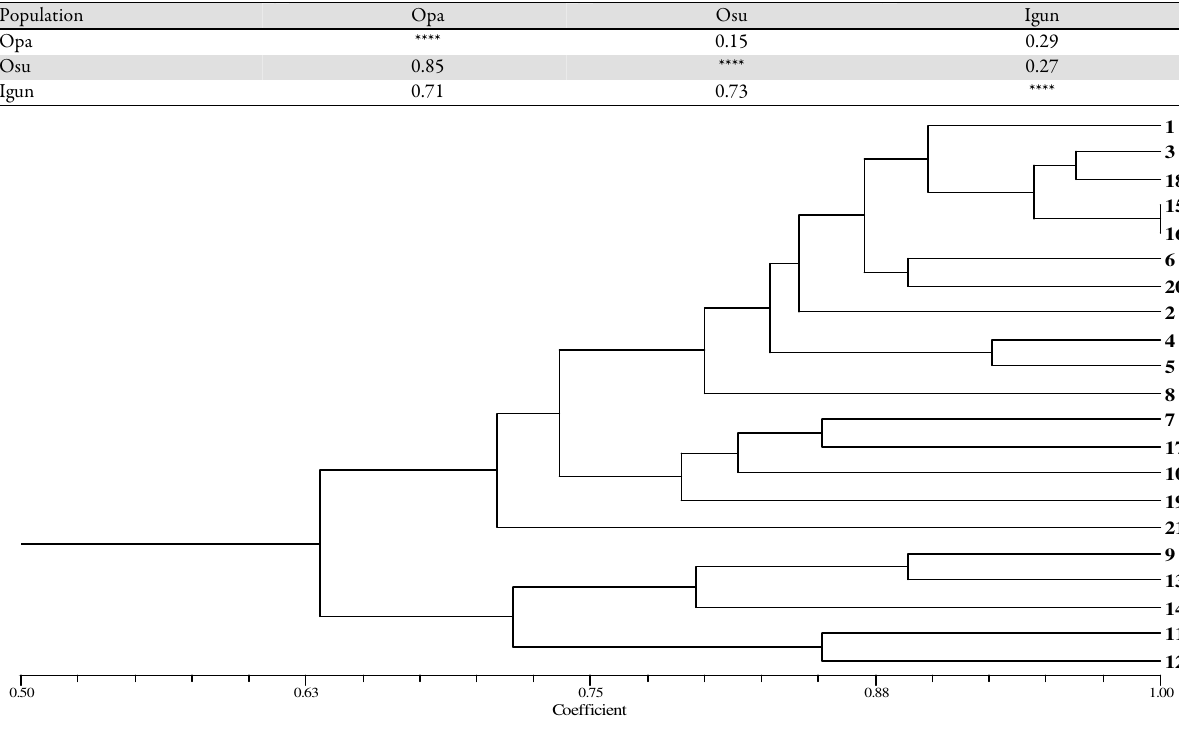
Coefficient Fig. 6. UPGMA dendrogram, summarizing the data on differentiation between Tilapia zillii populations, according to RAPD analysis. Samples 1-7 is from Opa Reservoir, samples 8-14 is from Osu Reservoir and samples 15-21 is from Igun Reservoir